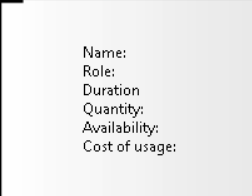
Fig. 2. Expanded element with resource information.